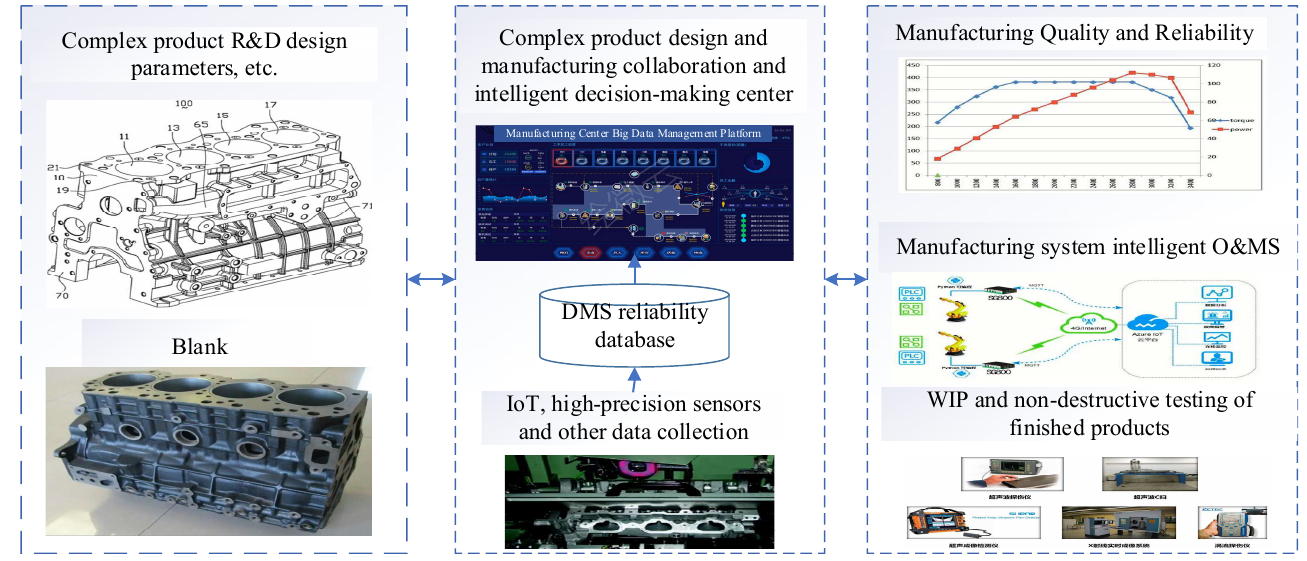
Figure 7. Engine block machining process reliability and optimization.